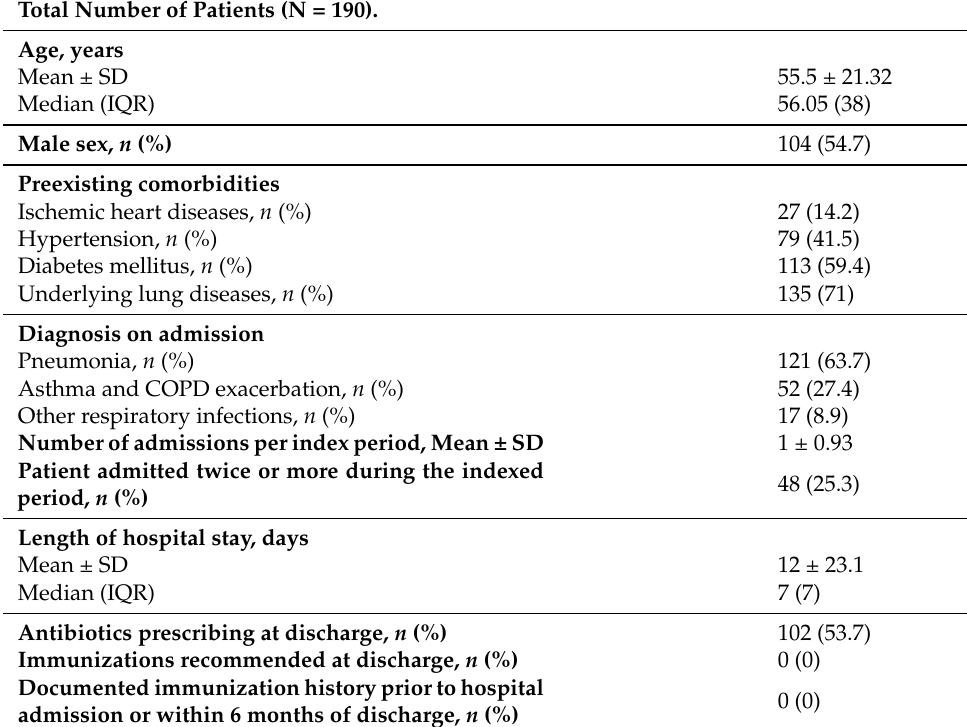
Table 1. Baseline